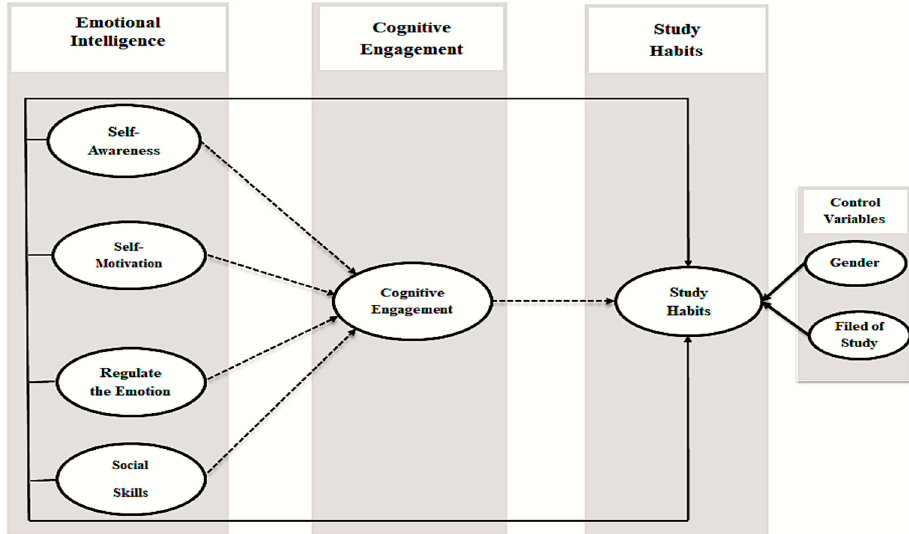
Figure 1. Research framework.